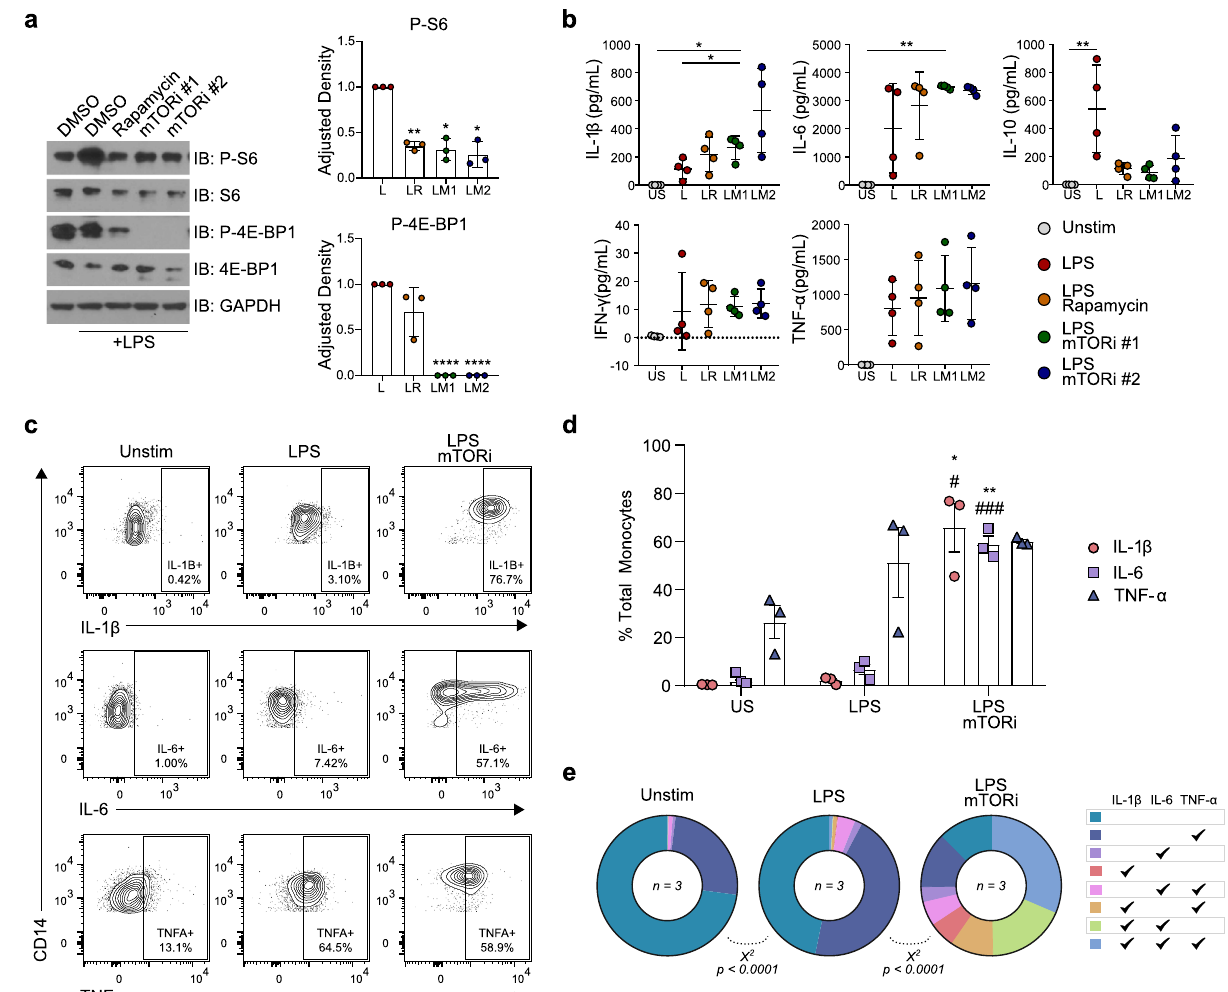
Fig. 1 mTOR inhibition potentiates the in fl ammatory phenotype of primary uninfected human monocytes following TLR4 stimulation. a Freshly isolated human monocytes were pretreated as indicated with rapamycin (100 nM) or one of two structurally distinct mTORi (AZD2014, mTORi #1; INK128, mTORi #2; each 5 μ M) or DMSO for 6 h prior to stimulation with LPS (1 μ g, 30 m). Representative western blot series from one independent donor of three quanti fi ed, with adjusted density representing fold change of phosphorylated target staining, normalized to GAPDH staining, relative to the stimulated control (LPS). b Monocytes from four donors were pretreated as in a , stimulated with LPS (1 μ g, 24 h), and supernatant cytokine content was quanti fi ed on the MSD platform. c – e PBMCs from three donors were pretreated with AZD2014 for 6 h and stimulated with LPS (1 ng, 18 h) prior to staining. Representative fl ow plot ( c ) and aggregates ( d and e ) represent gating on leukocyte/singlet/live/CD14 + . Boolean gating ( e ) facilitated identi fi cation of subpopulations producing different combinations of cytokines. e Illustrates that some monocytes produced no cytokines at all (turquoise), whether unstimulated, only stimulated with LPS, or stimulated with LPS after mTORi pretreatment. In contrast, the color coding described in the rightmost panel in e indicates that others produced one cytokine or different combinations of two or three cytokines, with “ polyfunctionality ” being de fi ned as production of 2 or 3 cytokines in different combinations. Enahnced polyfunctionality was seen among the mTORi pretreated, LPS-stimulated monocytes. Statistical analyses: for the blot quanti fi cation ( a ), signi fi cance was determined using an ANOVA with Dunnett ’ s multiple comparisons, and asterisks (*) indicate a comparison to the stimulated control. For b , signi fi cance was determined via one-way ANOVA Tukey ’ s multiple comparisons, except in cases where Friedman tests and Dunn ’ s multiple comparisons were appropriate. For d , asterisks (*) indicate comparisons between US and LPS/mTORi (AZD2014) and hashes (#) indicate comparisons between LPS and LPS/mTORi (AZD2014), and signi fi cance was computed via two-way ANOVA and Tukey ’ s multiple comparisons. */# p < 0.05, **/## p < 0.01, ***/### p < 0.001. Error bars represent mean ± SD. For e , cytokine pro fi les were compared using